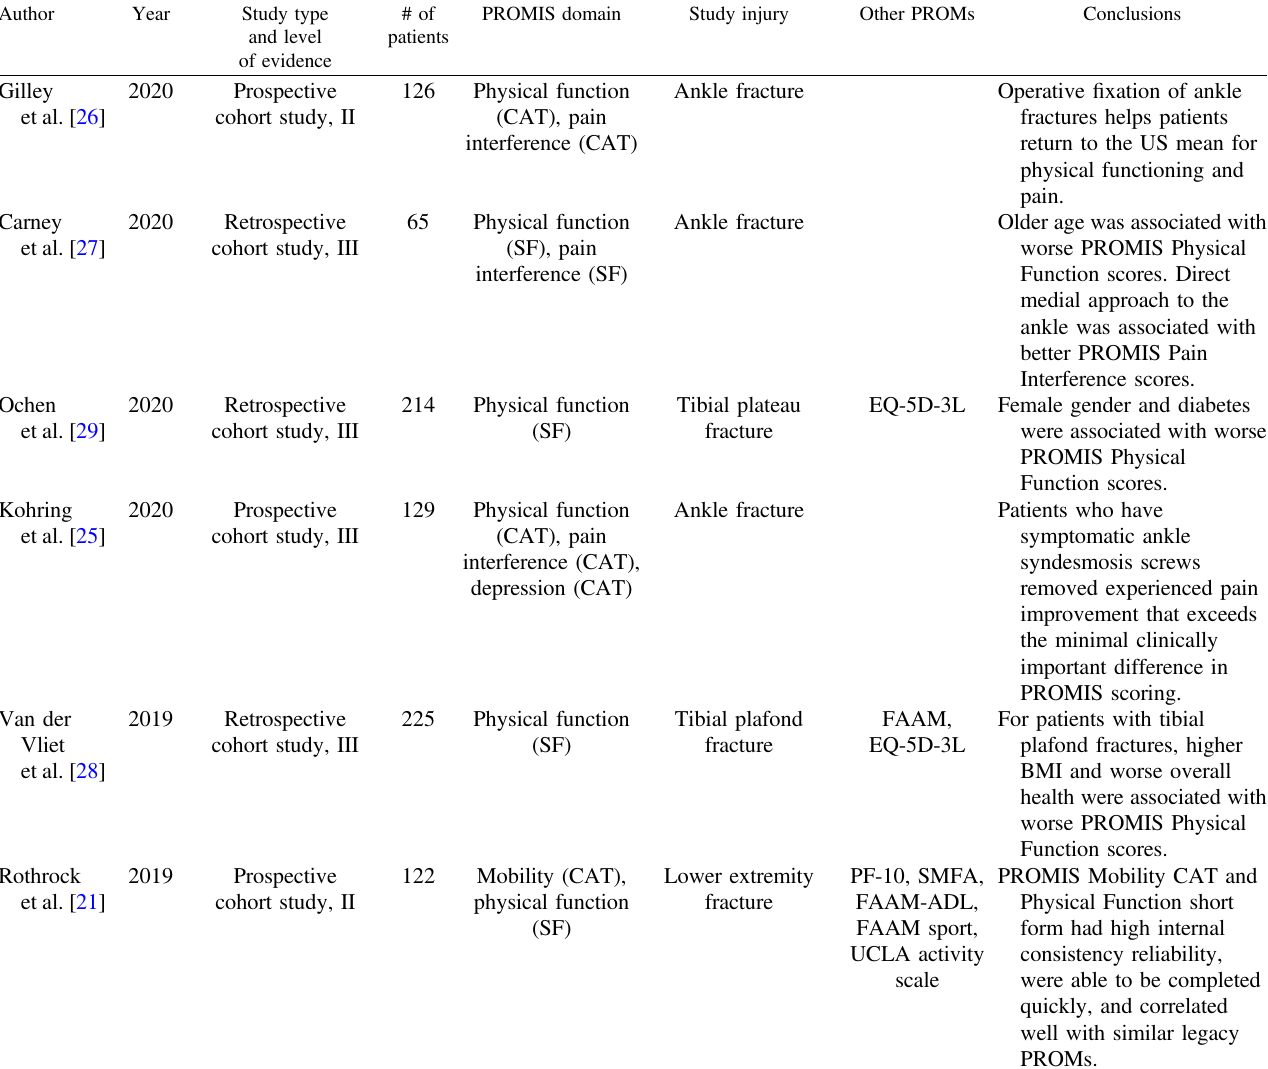
Table 2. PROMIS and lower extremity